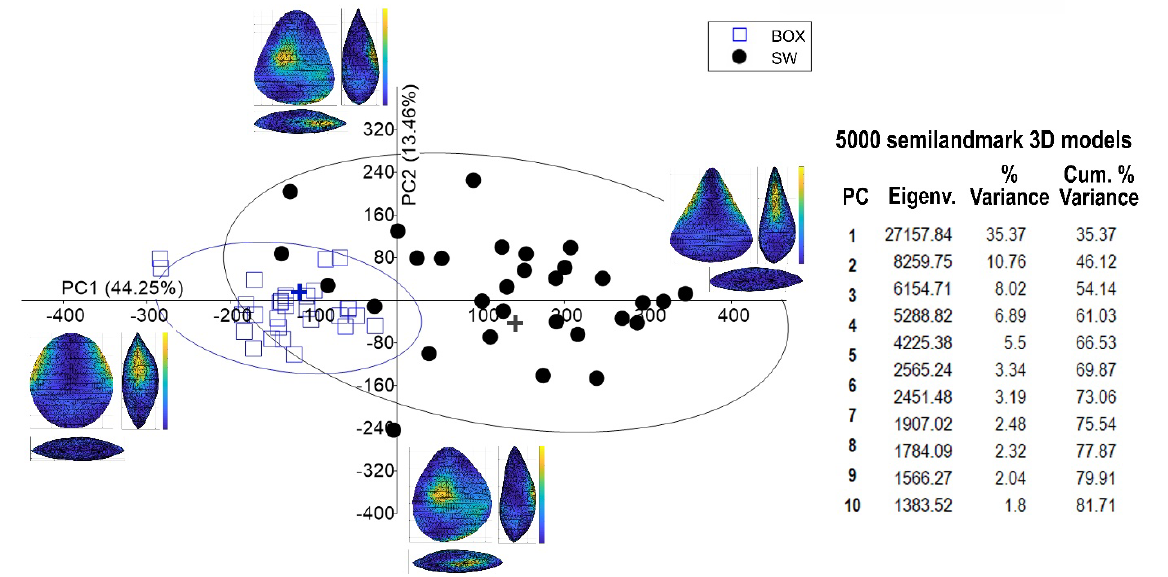
Figure 6. Principal components scatter plots of handaxes from Boxgrove (blue square) and Swanscombe (Black dots). Outlines on 3D models, made on 5000 semi-landmarks, with their percentages of cumulative variance. The ellipses are 90% confidence ellipses. It includes the warps’ tool, representing the morphology. Colour coding represents the landmarks that vary the most on the shape trend described on positive and negatives scores of the PC1 and PC2. Two crosses represent the mean shapes of each